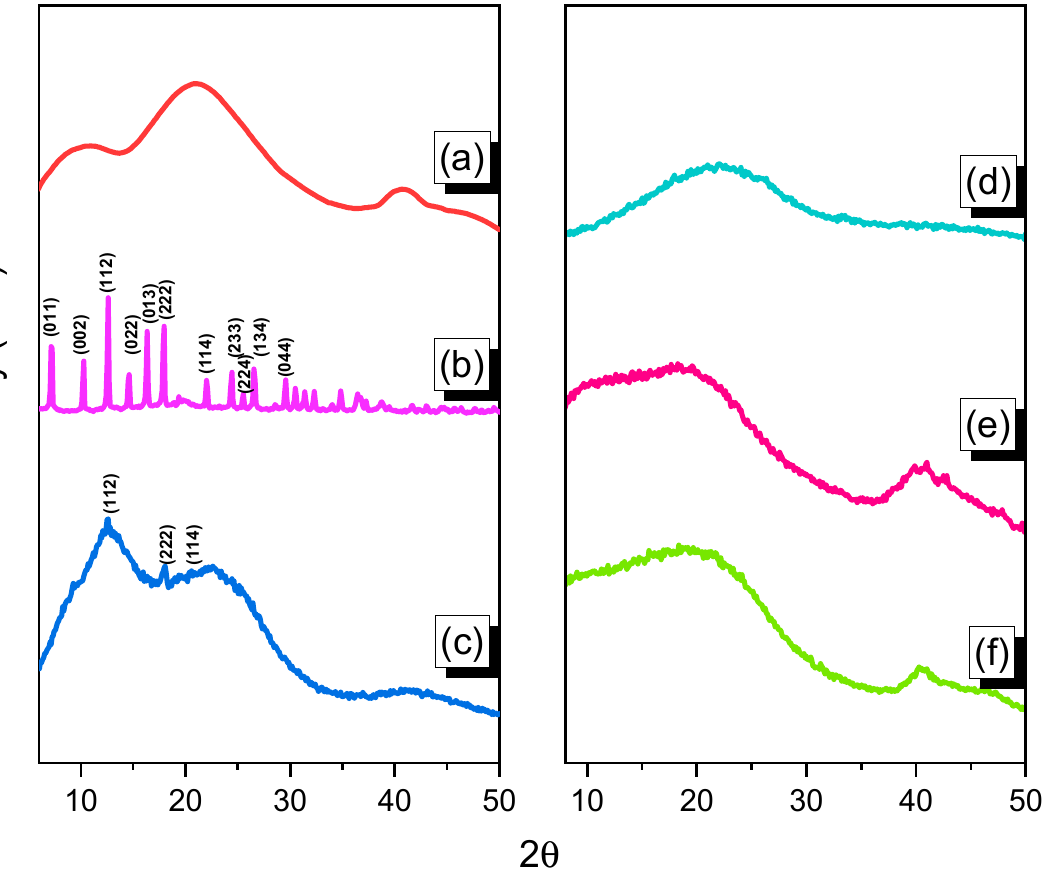
Figure 5. XRD profiles of ( a ) PA-BZ POP, ( b ) ZIF-67, ( c ) PA-BZ POP/ZIF-67, ( d ) PA-BZ POP/metal composite, ( e ) MPC, and ( f ) PCMC, recorded at room temperature.